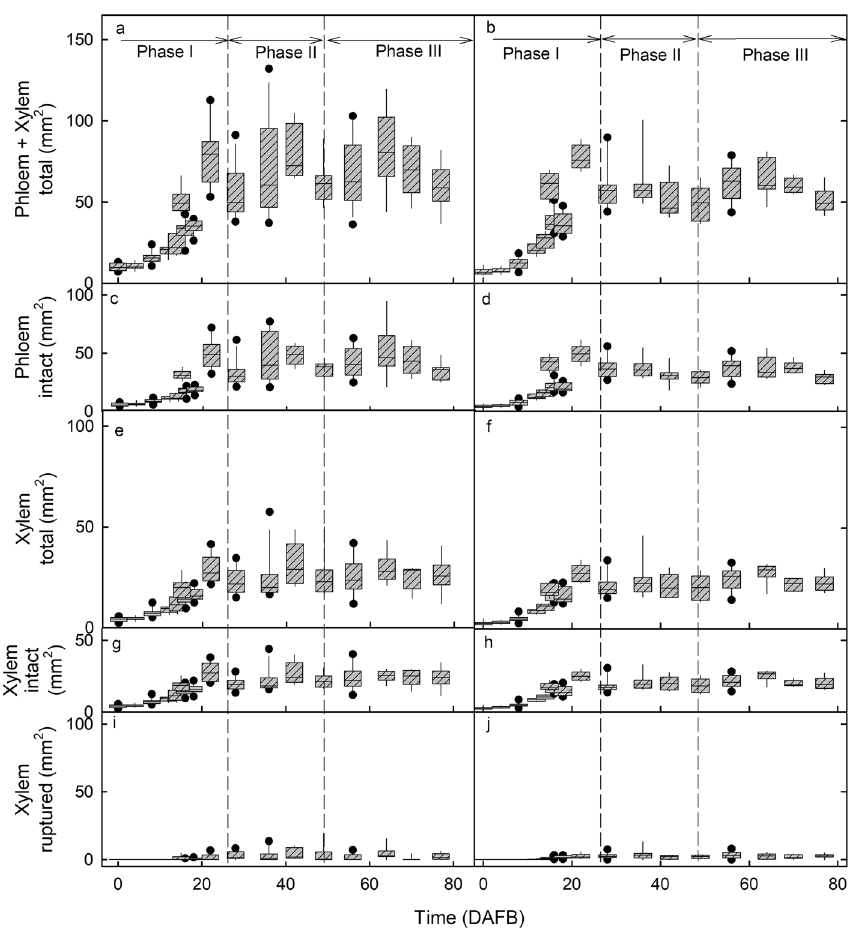
Figure 2. Developmental time course of change in cross-sectional areas of the median bundle ( a, c, e, g, i ) and the lateral bundle ( b, d, f, h, j ). ( a, b ) Whole bundle comprising xylem plus phloem. ( c, d ) Phloem. ( e, f ) Total xylem. ( g, h ) Intact xylem. ( i,j ). Ruptured xylem. The x -axis scale in days after full bloom (DAFB). The box represents the 25th and 75th percentiles, the horizontal line in the box the median, and the whiskers the 5th and 95th percentiles. Individual symbols beyond the whiskers are